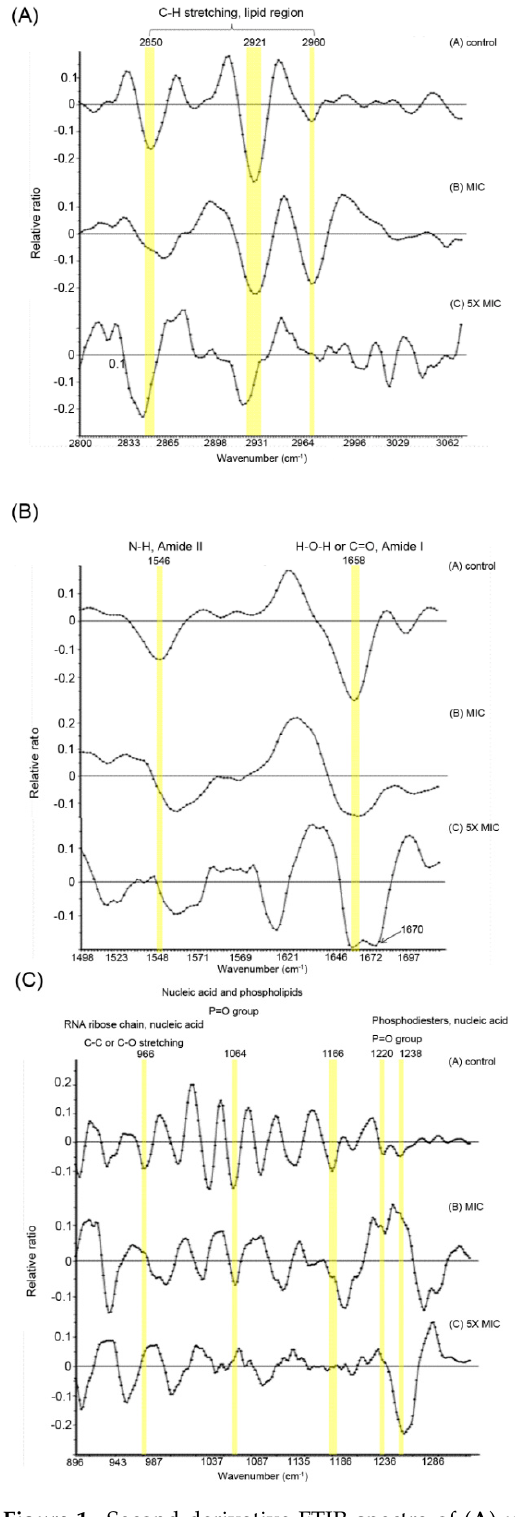
Figure 1. Second-derivative FTIR spectra of ( A ) untreated cells [n = 100], ( B ) cells treated with C 14 -KYR at MIC [n = 137], and ( C ) cells treated with C 14 -KYR at 5xMIC of C 14 -KYR [n = 113]. Assigned bands in FTIR spectra (highlighted in yellow) represent the lipid region (3000–2800 cm − 1 ), protein region (1700–1500 cm − 1 ), and carbohydrate and nucleic acids (1300–900 cm − 1 ). Each second- derivative spectrum was an average from all spectra processed using the Savitzky–Golay algorithm and normalized with extended multiplicative signal correction